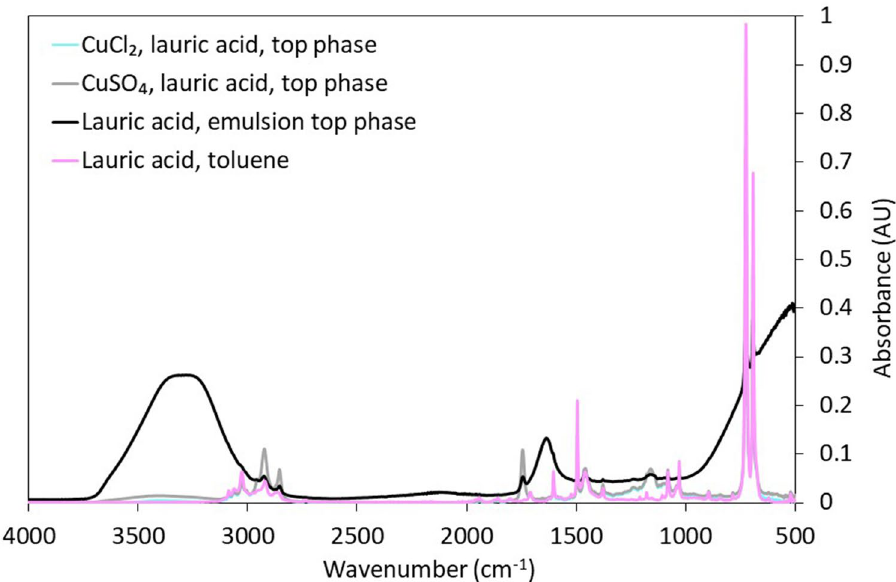
Figure 8. ATR-FTIR spectra of samples prepared with lauric acid in canola oil and toluene and DI water with 10 mM NaOH, with or without copper salts, and with lauric acid in toluene alone. ATR-FTIR spectra were collected for the top phase (i.e., the oil phase) of samples prepared using 5 mL of either 30 mM CuCl 2 or CuSO 4 solutions, and 2 mL of oil (containing 1:1 toluene to 0.25 M lauric in canola oil